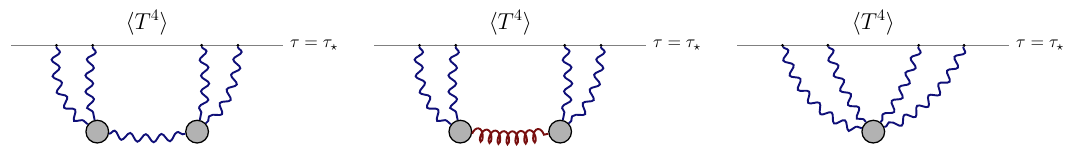
Figure 8 . Contributions to